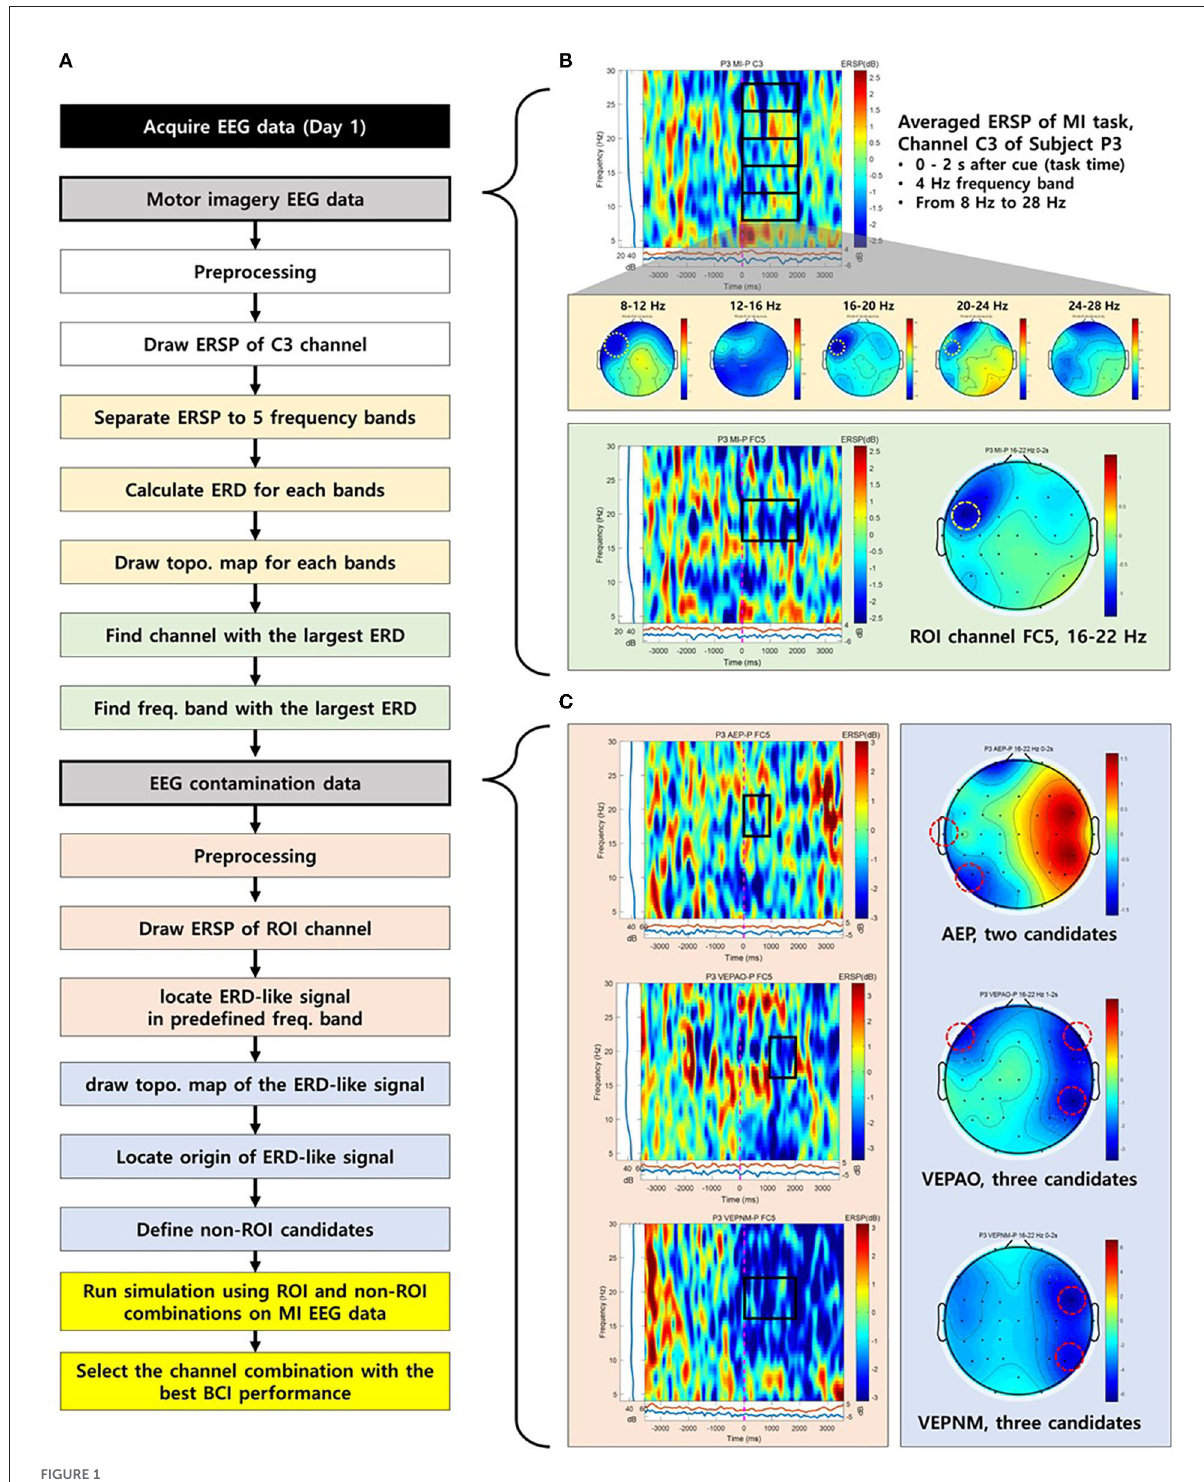
FIGURE1 The process to select a region of interest (ROI) and non-ROI candidate channels of a representative participant (P3). (A) The flow chart for the process to select ROI and non-ROI candidate channels. (B) The process to select a ROI. The yellow dotted circle on the topographical map represents the selected ROI. (C) Non-ROI candidate channels. The red dotted circle on the topographical map represents the source of electroencephalogram (EEG) contamination and candidate channels for